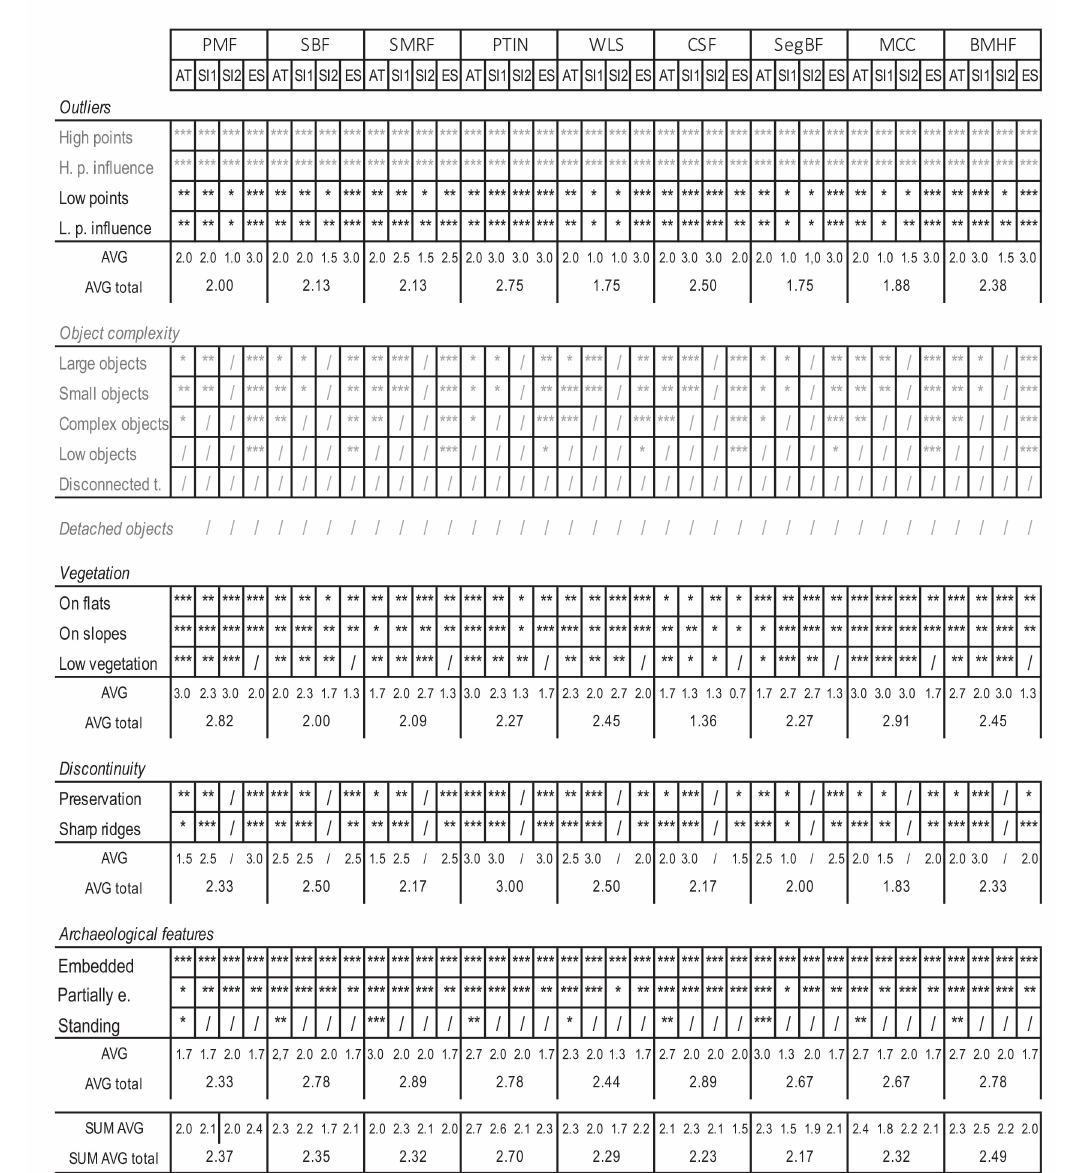
Figure 5. Qualitative assessment of the filters for ground point classification: good ***; fair **; poor *; Average (AVG) values. (After [20]: Figure 5, published under CC-BY